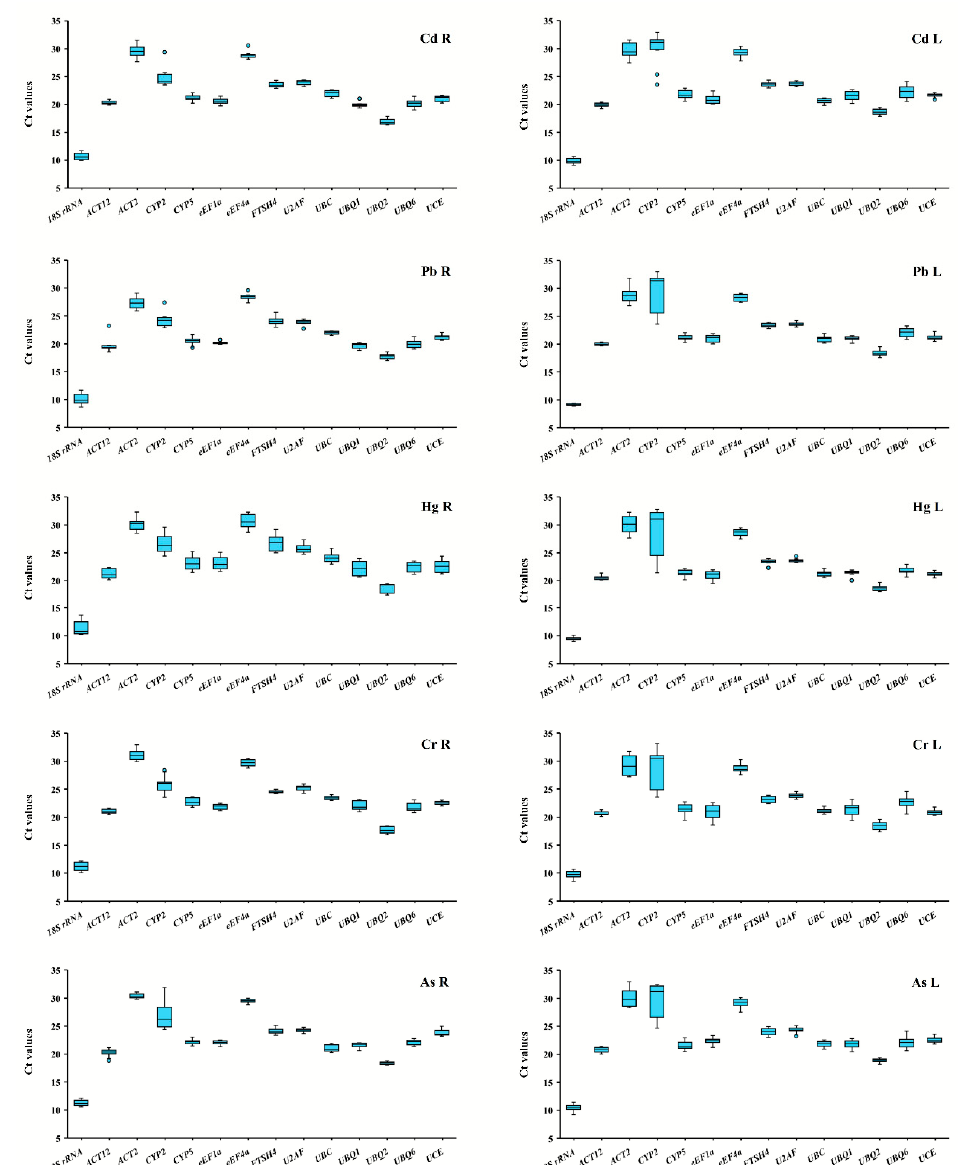
Figure 1. Median cycle threshold (Ct) values for fourteen candidate reference genes in switchgrass root and leaf samples under heavy metals stress conditions. The variation is displayed as medians values (lines across the box plot), 25th to 75th percentiles (boxes), and the maximum and minimum values (whiskers). Cadmium-treated leaves (CdL) and roots (CdR); lead-treated leaves (PbL) and roots (PbR); mercury-treated leaves (HgL) and roots (HgR); chromium-treated leaves (CrL) and roots (CrR); arsenic-treated leaves (AsL) and roots (AsR), the same below.